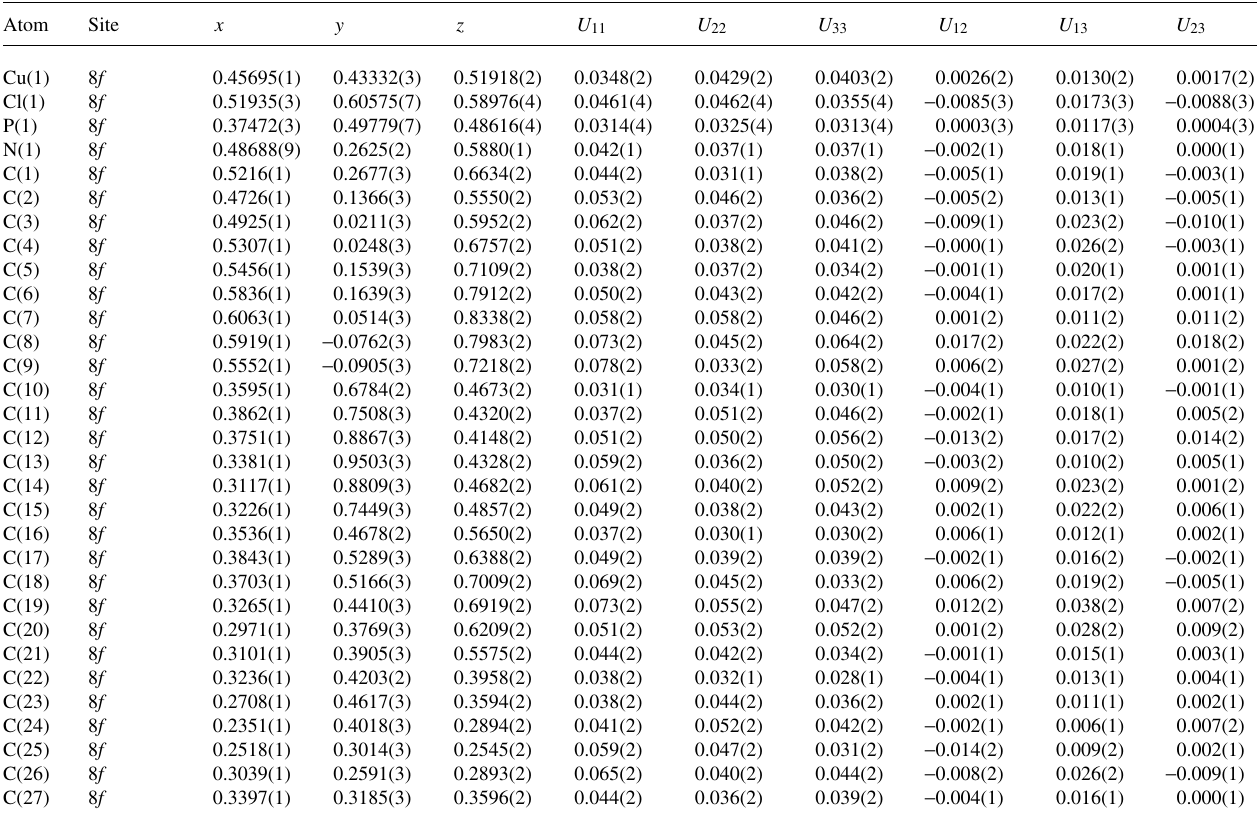
Table 3. Atomic coordinates and displacement parameters (in Å 2 ) .